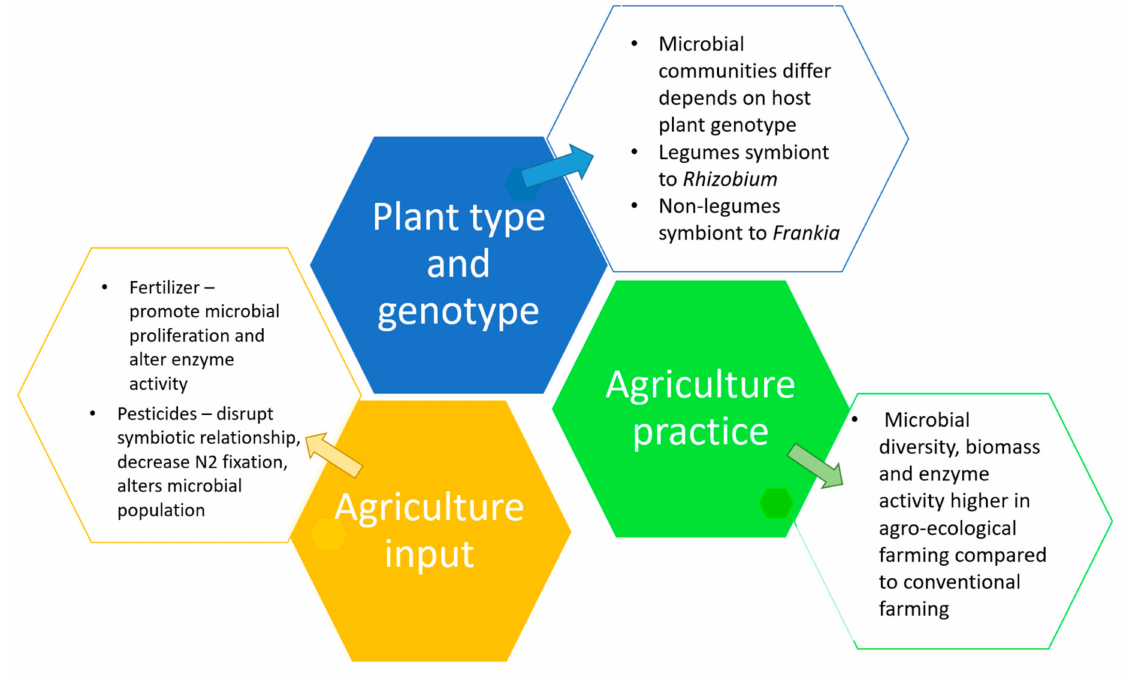
Figure 2. The connection between plant genotypes, agricultural practices and input on the soil microbial